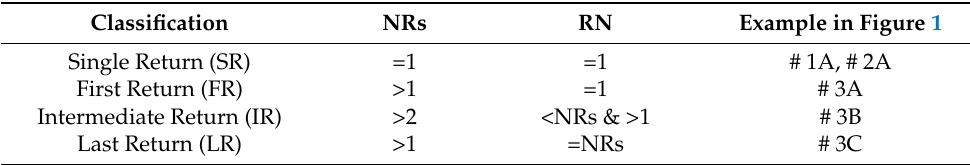
Table 1. Classification of returns based on the relationship between RNs and RN of each return. Classification RN Example in Figure